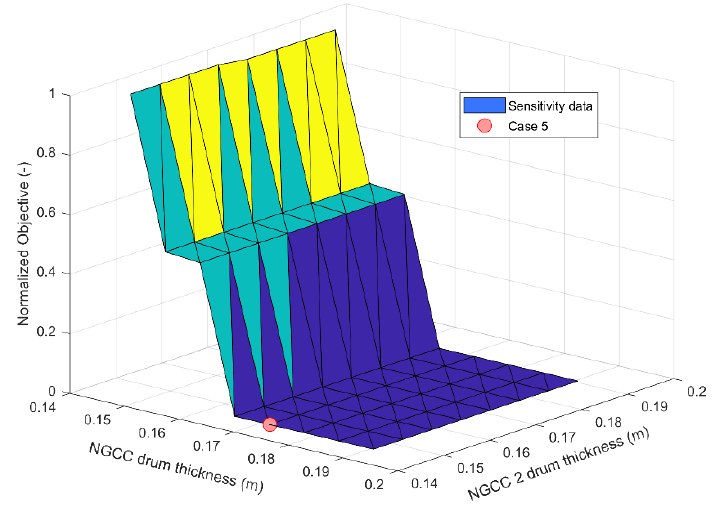
Figure 17. Modified variable renewable energy penetrations (solar/wind) for Case 5.